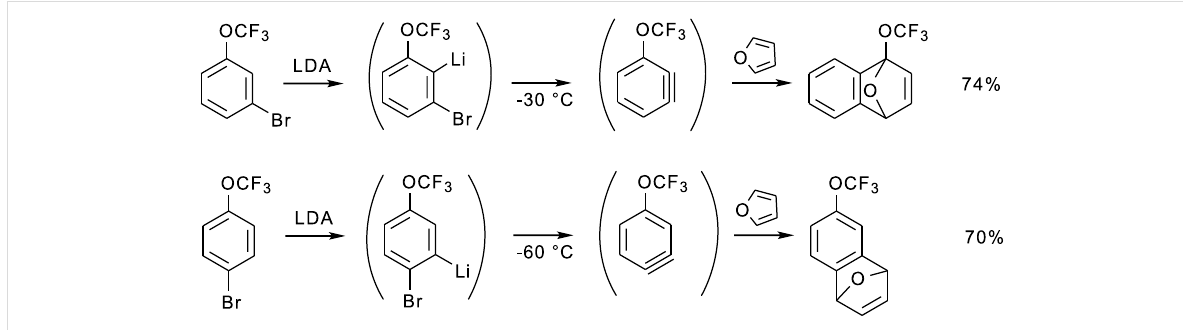
Scheme 19: Aryne formation from bromo(trifluoromethoxy)phenyllithiums and subsequent Diels-Alder cycloaddition with furan.